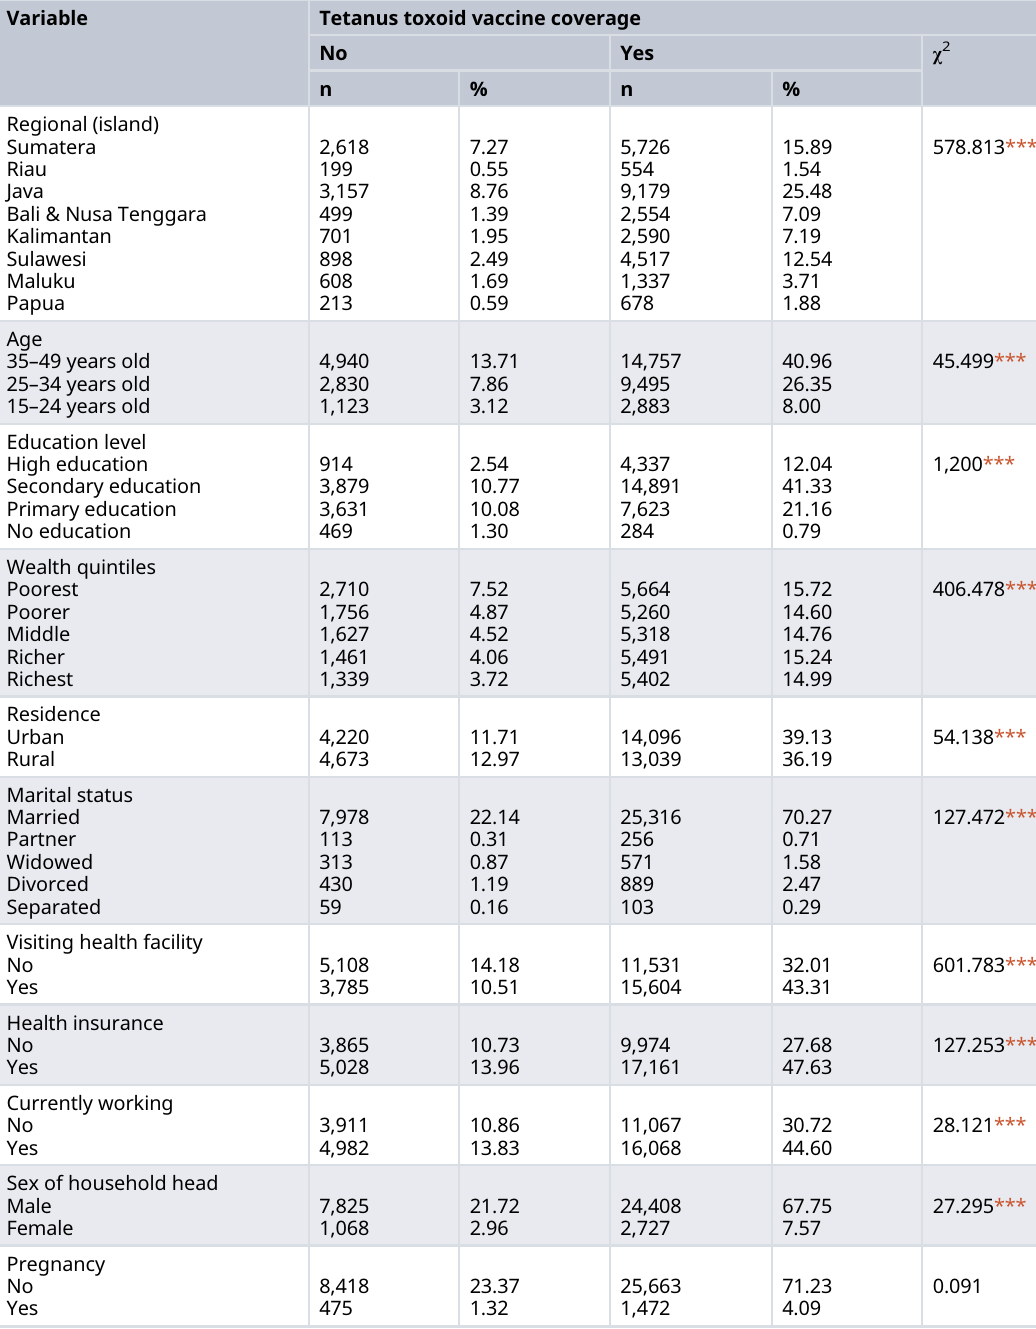
Table 2. Bivariate analysis of tetanus toxoid vaccine coverage among women aged 15 – 49 years in Indonesia (n =